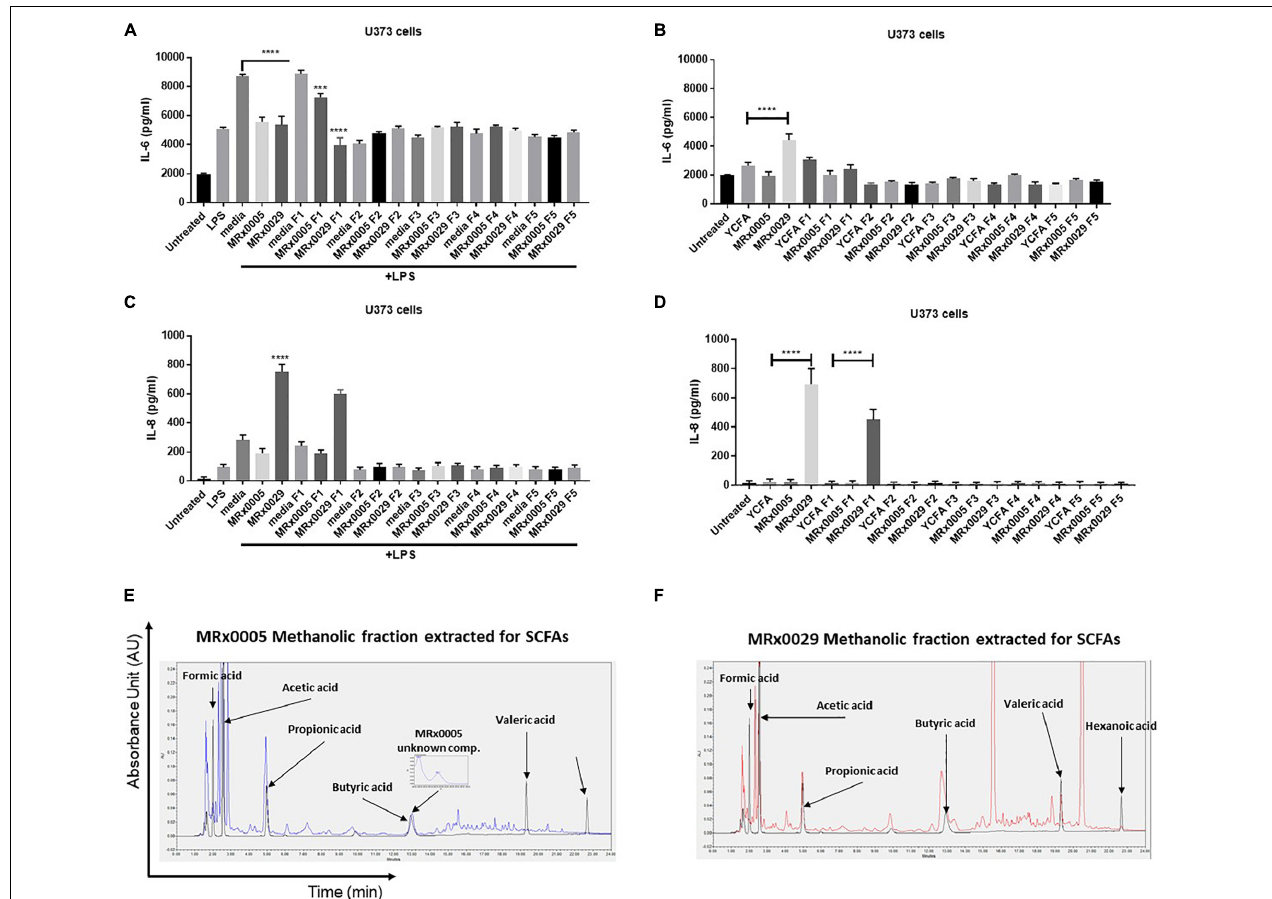
FIGURE 6 | Biochemical characterization and in vitro evaluation of the biological activity of MRx0005 and MRx0029 culture supernatant fractions. BCFS from three biological replicates from MRx0005 and MRx0029 were mixed with different solvents of increasing polarity and extracts used in cell-based assays. 10% BCFS, media alone, five different fractions and blank media treated with the same solvents used to prepare the fractions were added to U373 cells in the presence or absence of LPS as described in section “Materials and Methods.” Cell-free supernatants were collected 24 h after treatment and secretion of IL-6 and IL-8 was measured by ELISA. IL-6 secretion measured in U373 cells (A) pre-treated with 1 µ g/ml LPS or in the absence of LPS (B) ; IL-8 secretion measured in U373 cells (C) pre-treated with 1 µ g/ml LPS or in the absence of LPS (D). (E,F) The MeOH fractions from MRx0005 and MRx0029 were analyzed by HPLC for SCFAs band MCFAs. Representative examples of HPLC chromatograms are shown for MRx0005 and MRx0029. The methanolic fractions for MRx0005 (E) and MRx0029 (F) were extracted for SCFAs and MCFAs and then overlaid to a standard mix of SCFAs and MCFAs (Formic acid 10 mM, Acetic acid 20 mM, Propionic acid 10 mM, Butyric acid 10 mM, Valeric acid 10 mM, and Hexanoic acid 10 mM in black). The chromatograms highlight the lack of butyric, valeric and hexanoic acid in the MRx0005 methanolic fraction and their presence in the MRx0029 methanolic